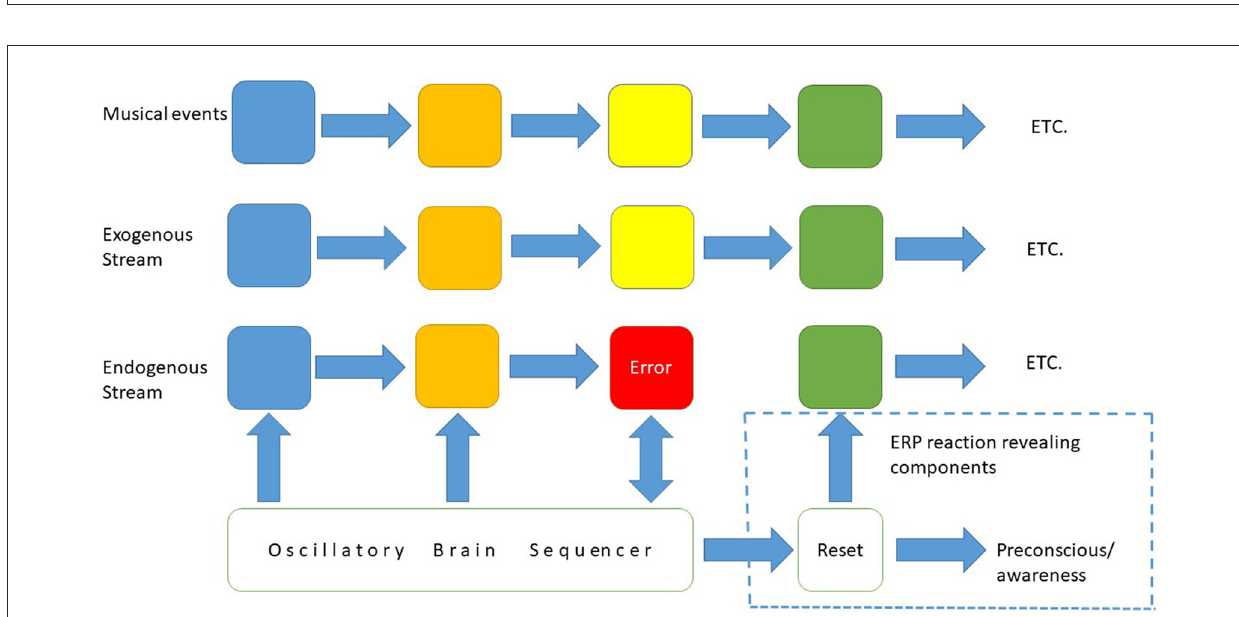
FIGURE2 Musical enactment/mismatch. The figure shows interaction between the exogenously induced sequence (in the auditory nerve) and endogenous sequences pre-taking oscillations (presented in Figure 1). Matches in color signify structural coupling (matching information). The event (in red) is a mismatch (a desynchronization of sequences), detectable in ERP as the “prediction error”. This implies a reset of the endogenous pre-taking sequence. ERP reaction times separate components in ERP potentials: reactions on strong anticipations from weak anticipations, and unattended mismatches from attended